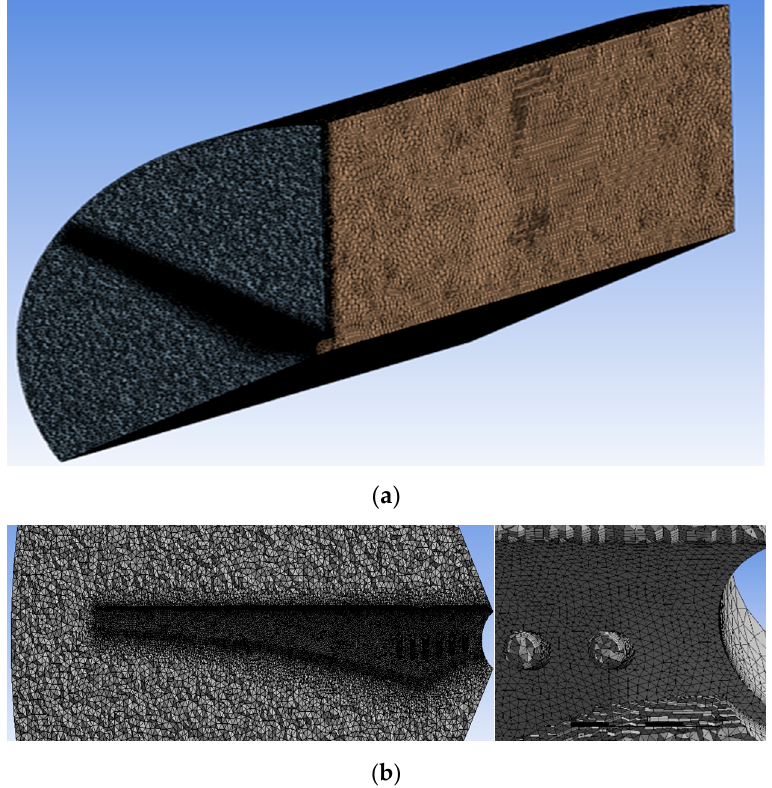
Figure 3. ( a ) The mesh structure of the 3D model; ( b ) The mesh structure around of the blade and air ducts.